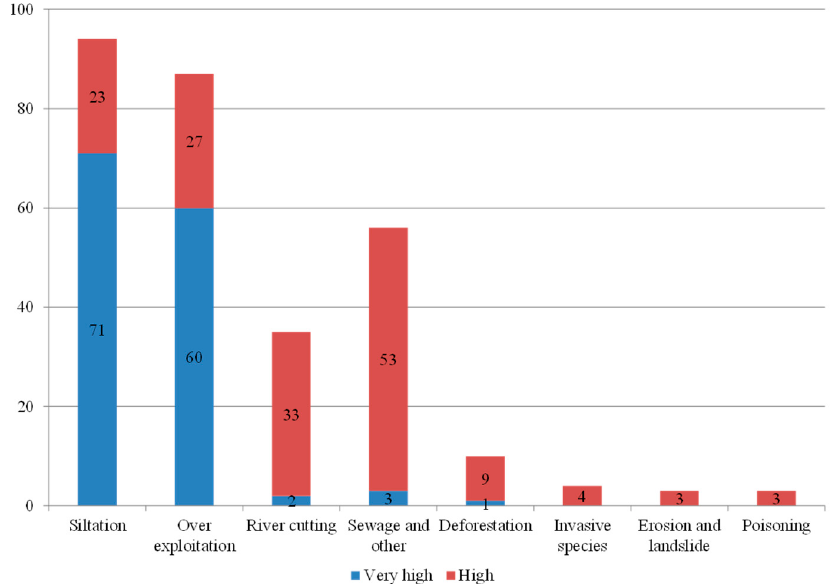
Figure 4. Direct drivers of change through household surveys.